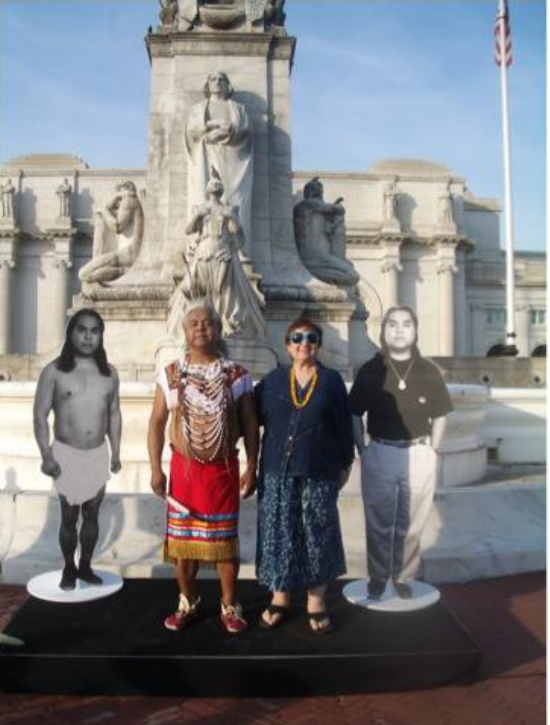
James Luna, Take a Picture with a Real Indian , 2010. Live performance- installation with